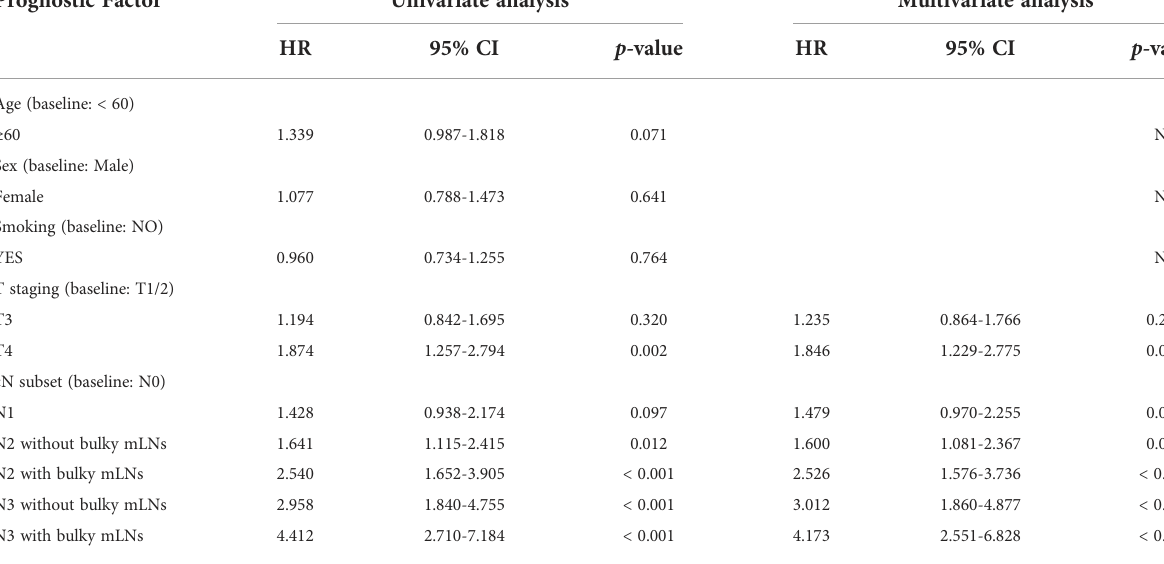
TABLE 3 Univariate and Multivariate Cox regression analysis for the OS of NSCLC patients.